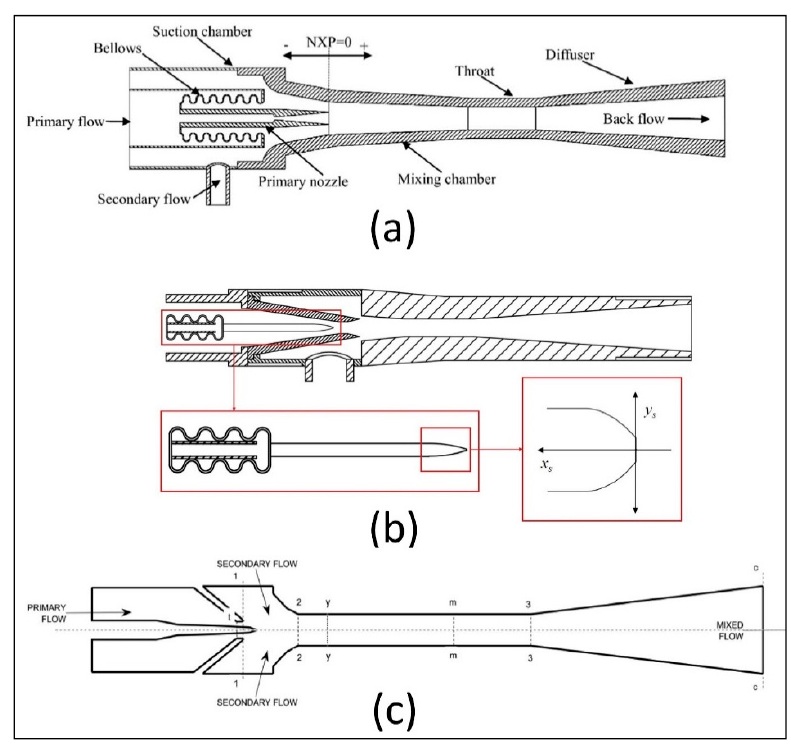
Figure 15. Internal adjustment mechanisms: ( a ) self-positioning nozzle [104]; ( b ) self-adjusting spindle [105]; ( c ) nozzle and spindle shape [106].